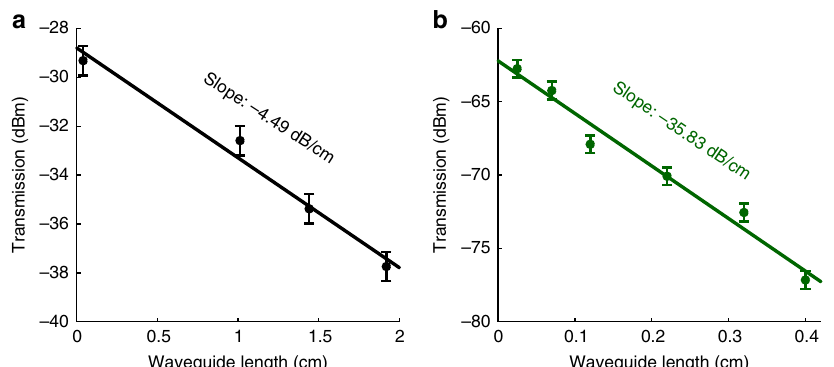
Fig. 5 Transmission characterization of the uncoated and hybrid slot waveguides. Transmission of the signal beam ( λ c = 1533 nm) at the output of a 0.04, 1.01, 1.44, and 1.92 cm long uncoated Si 3 N 4 slot waveguides and b 0.025, 0.070, 0.120, 0.220, 0.320, and 0.400 cm long Er:Al 2 O 3 – Si 3 N 4 hybrid slot waveguides. In a and b , the solid points correspond to the experimentally measured transmission values with ±0.60 dB signal level accuracy, whereas the solid lines are the theoretical linear least-squares fi ts to the transmission data with R 2 = 0.9797 and R 2 = 0.9726,